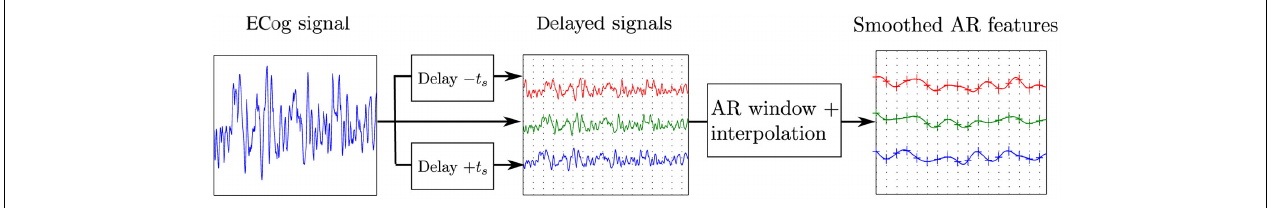
FIGURE 2 | Diagram of the feature extraction procedure for the moving finger decoding. Here, we have outlined the processing of a single channel